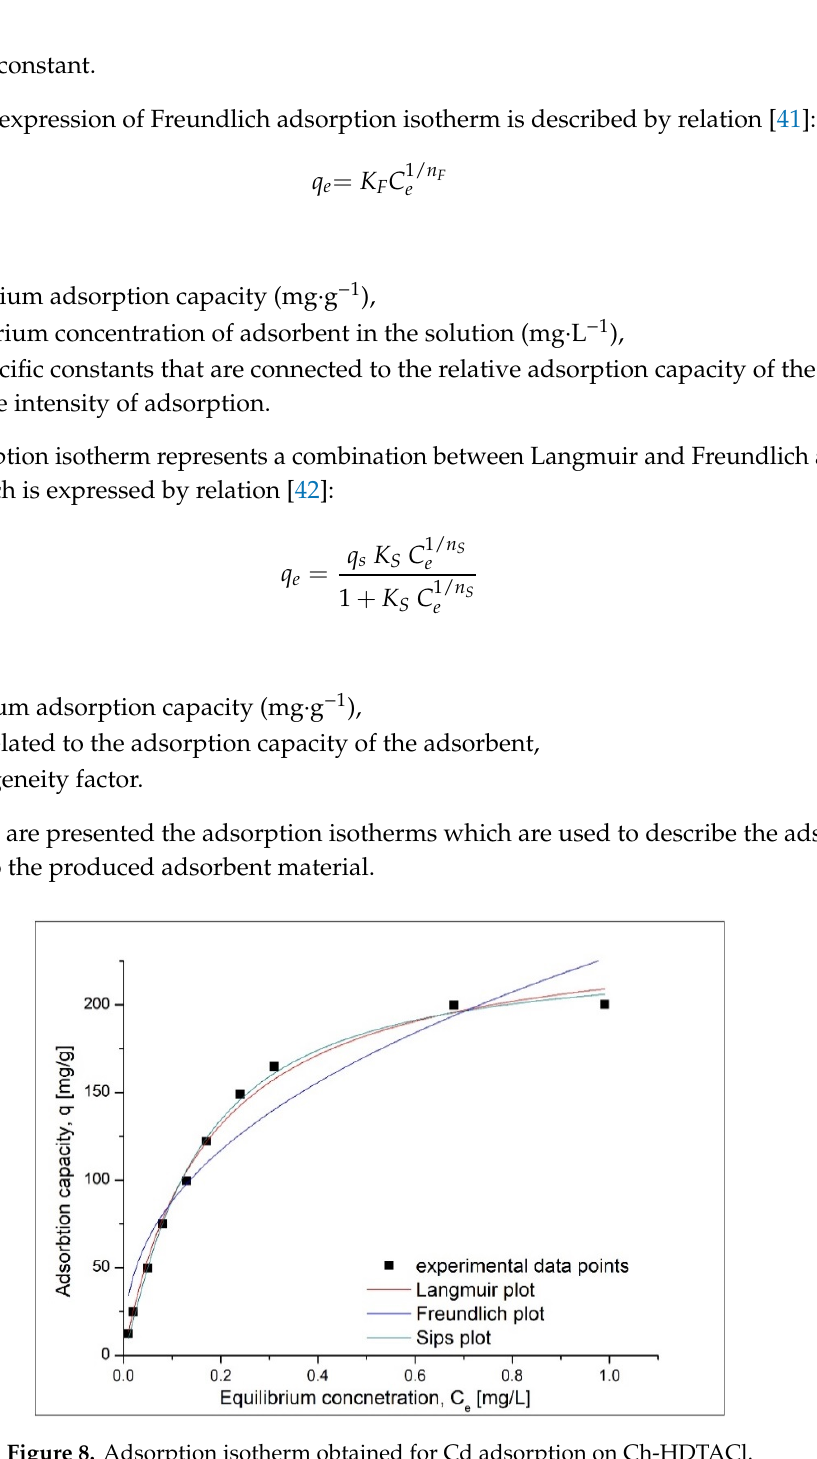
Figure 8. Adsorption isotherm obtained for Cd adsorption on Ch-HDTACl.